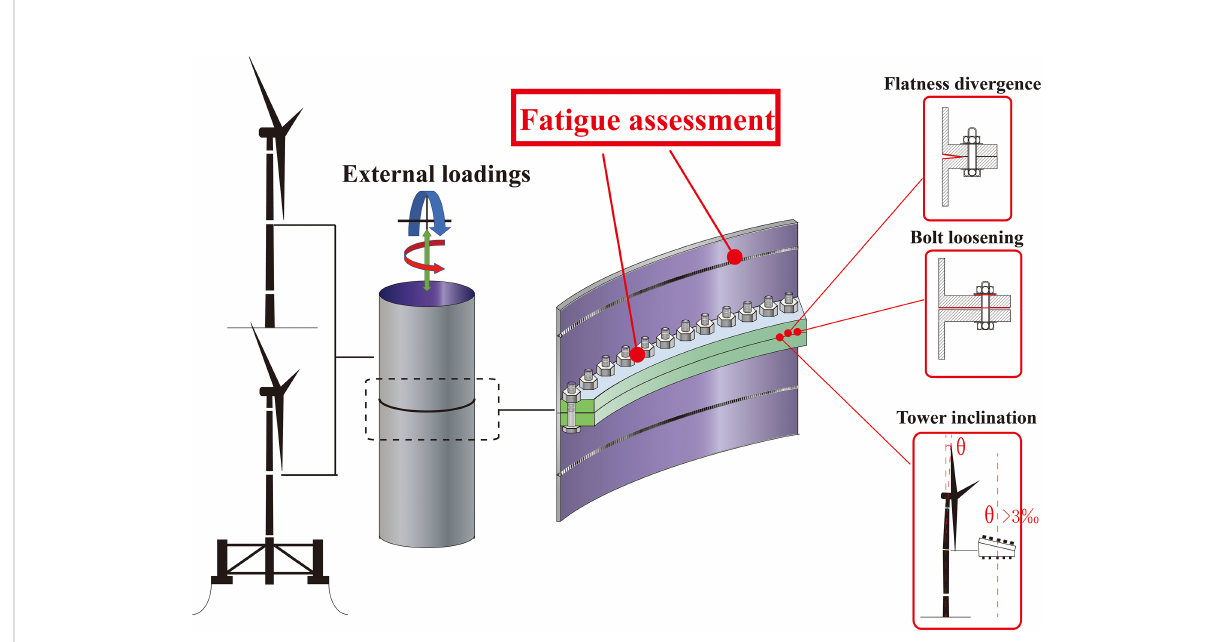
FIGURE 1 Initial imperfections in offshore wind